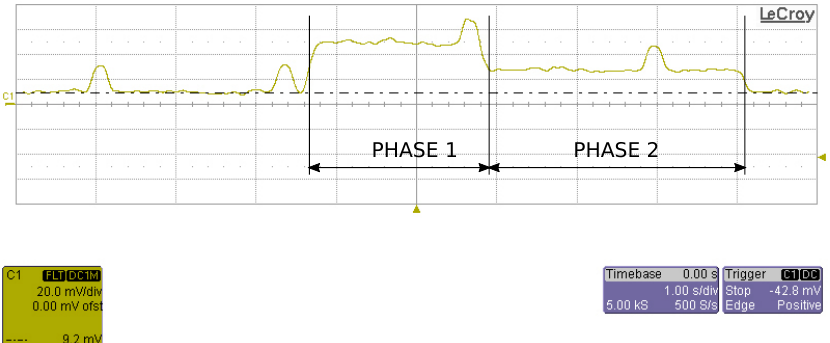
Figure 15. Oscilloscope record of power consumption (voltage over 1 Ohm resistor) during sensing and